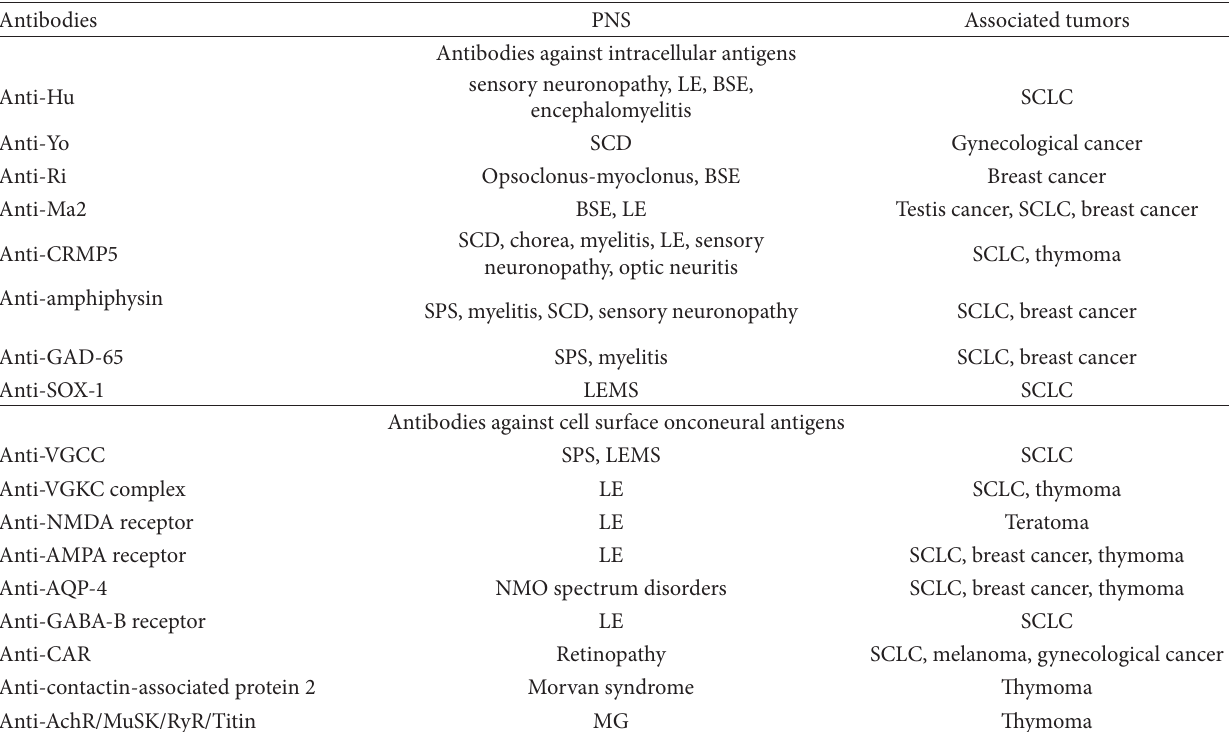
Table 4: The common antibodies detected in PNS and their associated